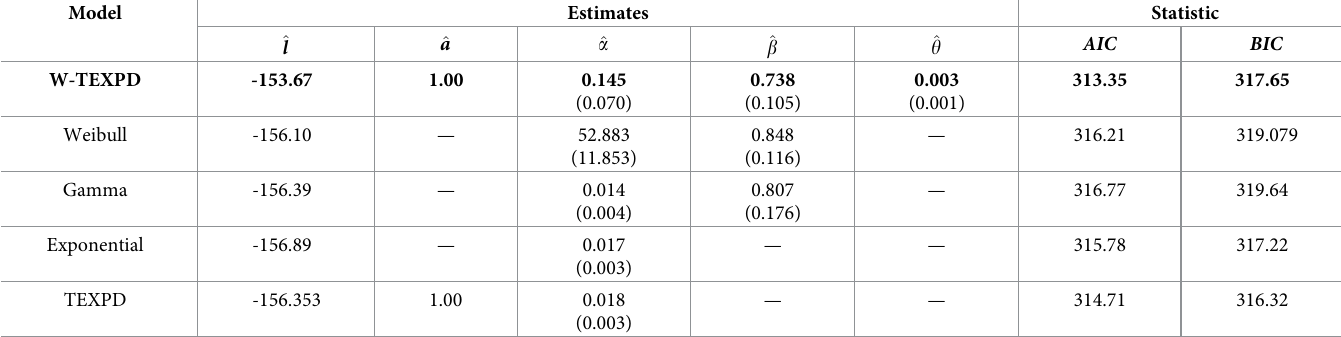
Table 3. Negative log-likelihood values ( ^ l ), MLEs of model parameters, the corresponding SEs (given in parentheses) and the statistics AIC and BIC of failure times of 31 air conditioning system of airplane. Model